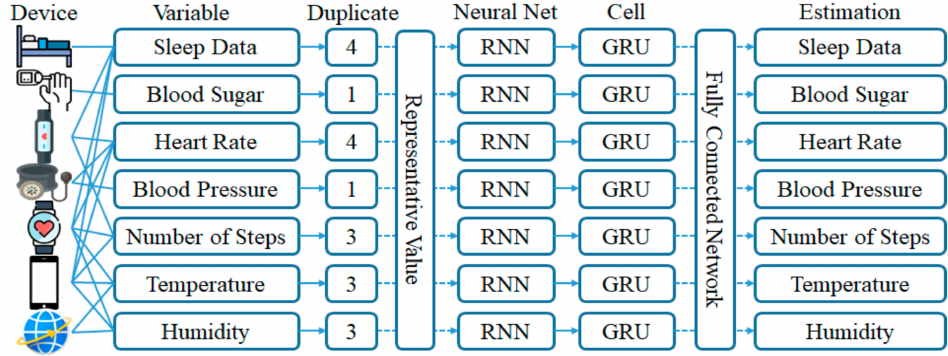
Figure 1. RNN-based multimodal deep learning for estimating missing